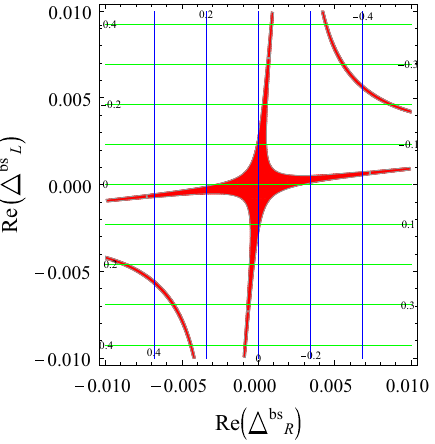
Fig. 4 Left contours of Re ( C Z (cid:3) color normalized by the SM Wilson coefficient C SM LRS corresponding to the case Im ((cid:5) sb Right contours of Im ( C Z (cid:3)